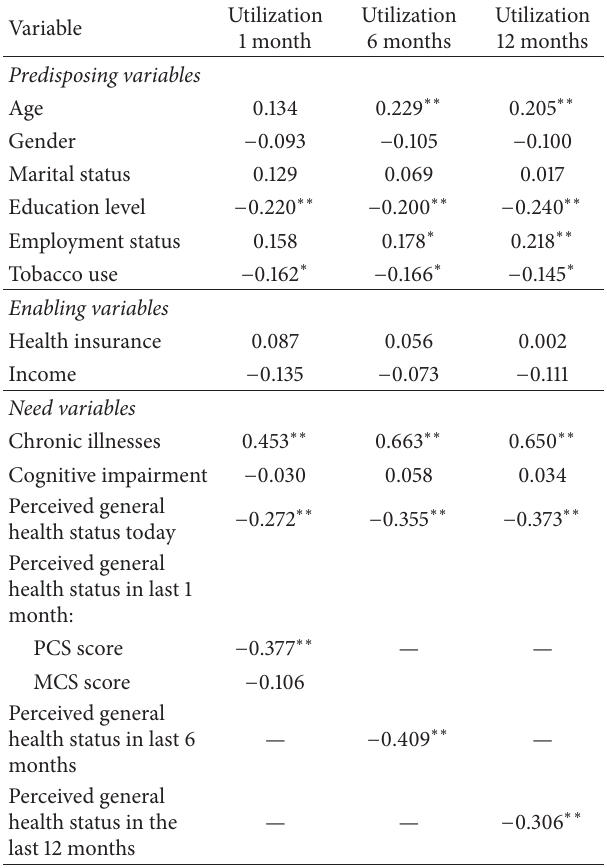
Table 2: Factors associated with primary health care services utilization of older adults in the past 1, 6, and 12